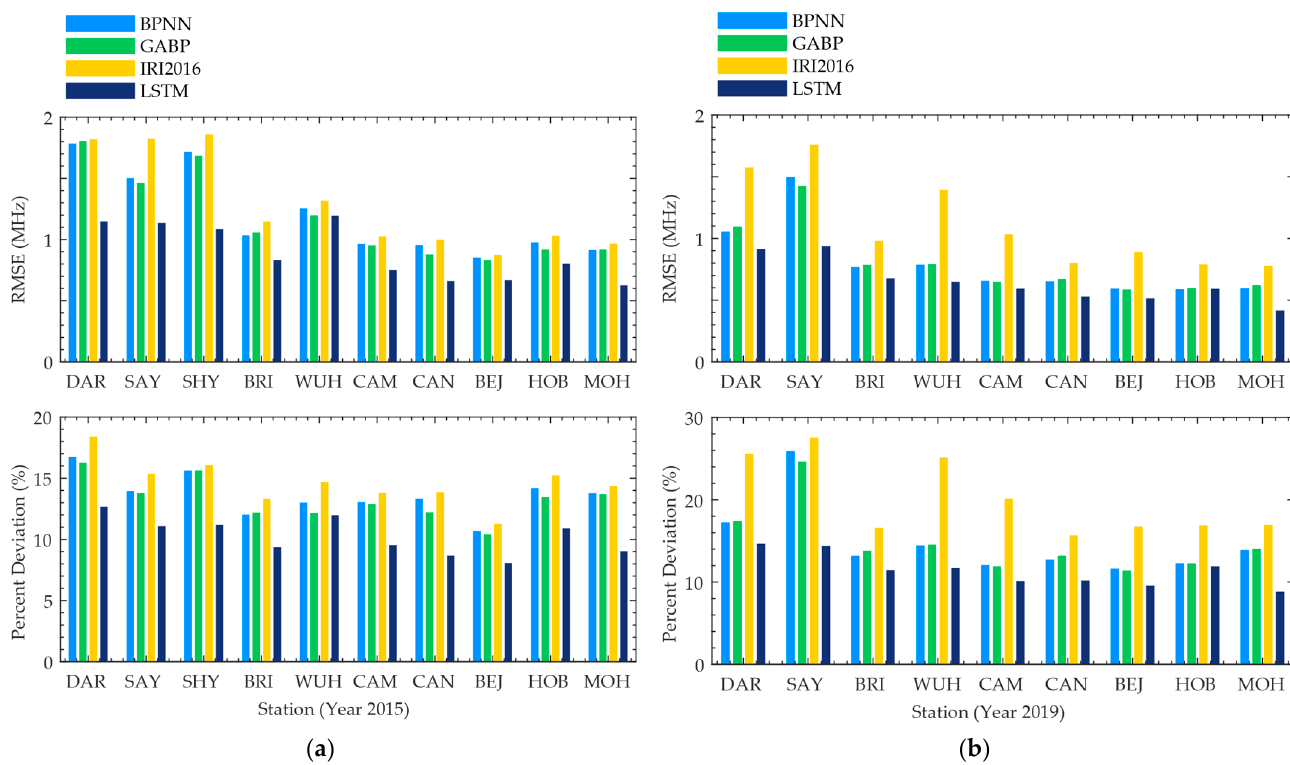
Figure 5. Bar graph illustrations of RMSE differences and PD differences between observed and forecasting foF2 values by 4 models: ( a ) During the year of solar maximum (2015); ( b ) During the year of solar minimum (2019).